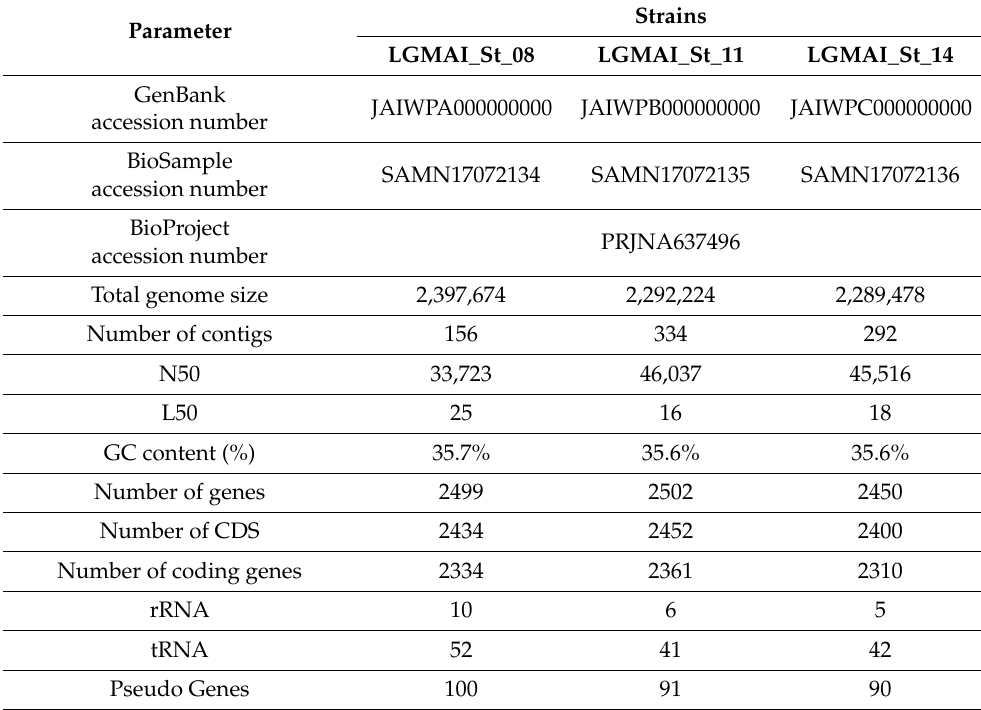
Table 7. Genome statistics obtained from assemblers and side